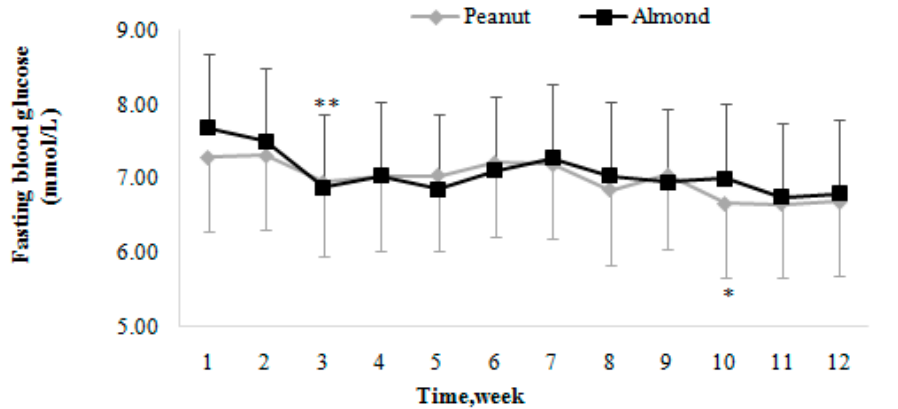
Figure 3. The changing trends of fasting blood glucose (FBG) in the Peanut and Almond groups. Values are means, with their standard deviations represented by vertical bars. For the Peanut group, * FBG was significantly lower at the tenth week than that at the sixth week ( p = 0.035). For the Almond group, ** FBG was significantly lower at the third week than that at the first week ( p = 0.001).